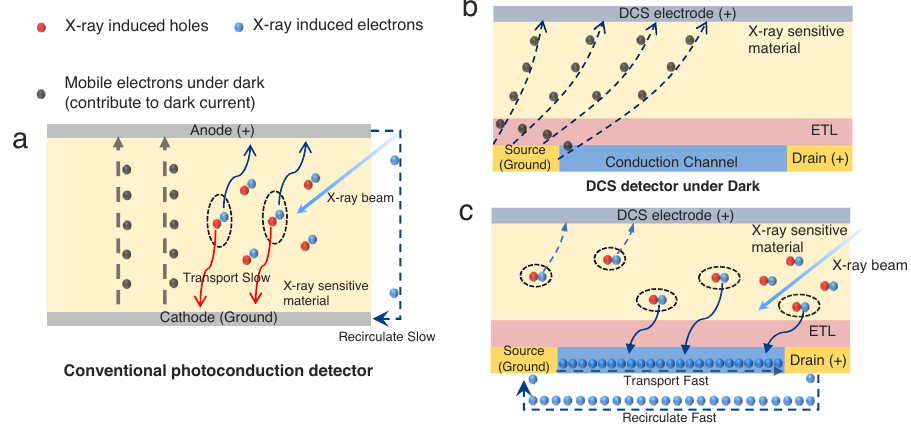
Fig. 1 | Working mechanism of dark-current-shunting (DCS) detector and conventional photoconduction detector. a Working mechanism of conven- tional photoconduction detector. The dark current and photocurrent are con- ducted in the same path and collected by the same electrodes. b Working mechanism of dark-current-shunting (DCS) detector. The electrons in the dark are emitted from the source and collected by the DCS electrode. c The X-ray induced electrons are generated from X-ray sensitive material and part of them